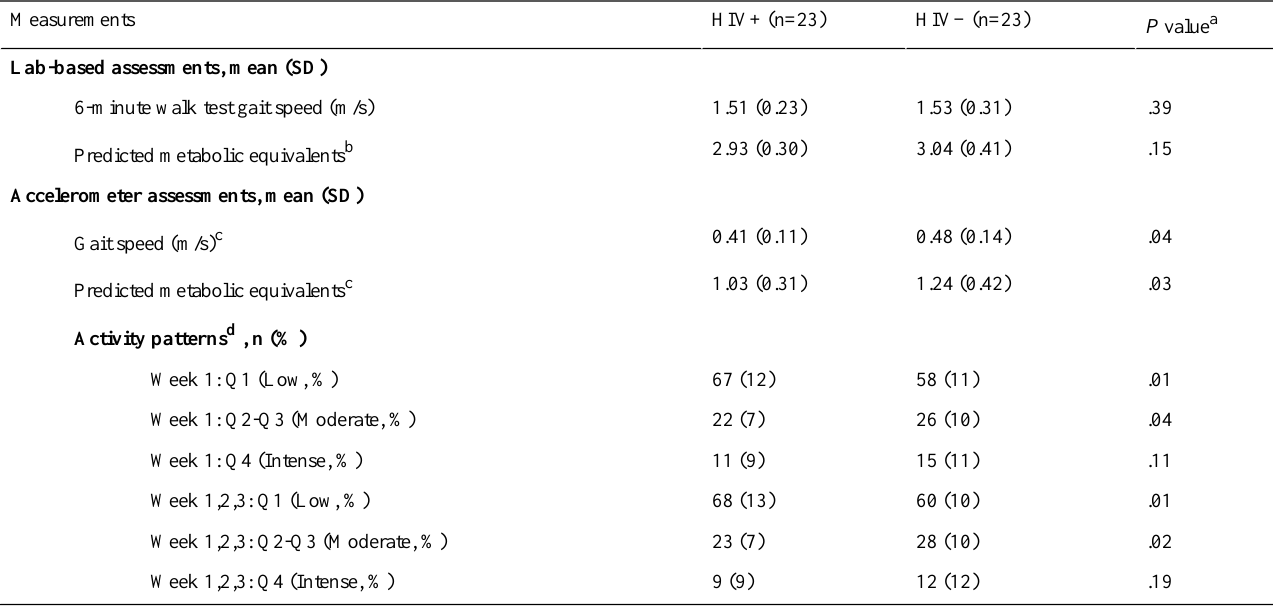
Table 3. Lab-based and accelerometer-based measurements of physical function and activity